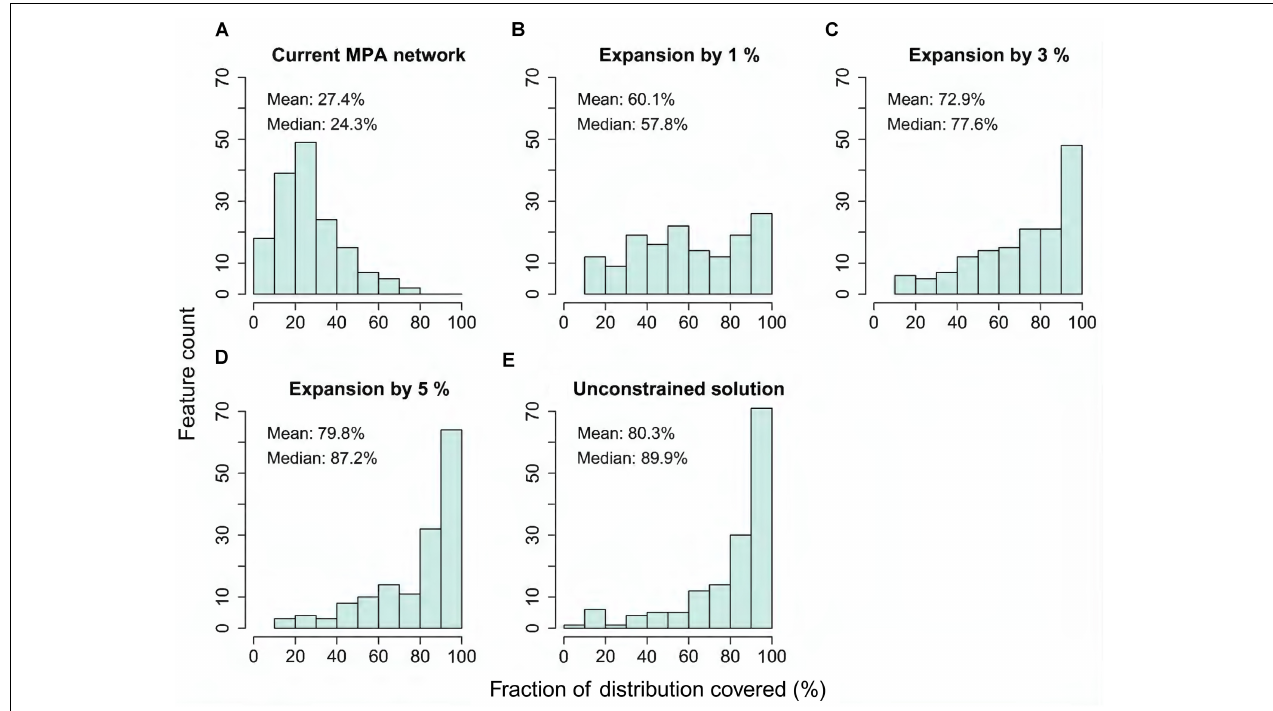
FIGURE 6 | (A–E) Histogram of coverage across all input features (excluding marine pressures) when selecting either the present MPA network, plus 1, 3, or 5% area expansions starting from the present network, compared to the ideal solution of the unconstrained analysis. The y -axis of the plot gives the count of features that have conservation coverage according to the bins on the x -axis. For example, the first bin 0–10% gives the count of features that have between zero and 10% of their occurrences covered in the selected set of